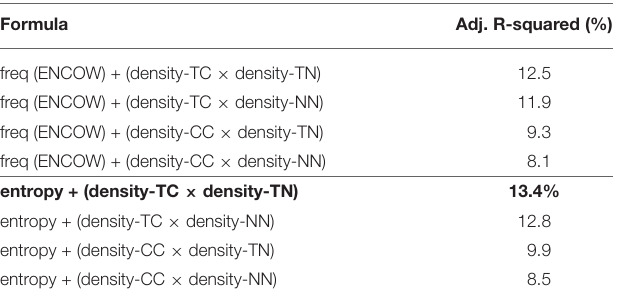
TABLE 4 | Linear regression output for the best predictor combination for nouns in the N-V-A condition: entropy + (density-TC × density-TN). Estimate Std. error t -value p -value RI (%)